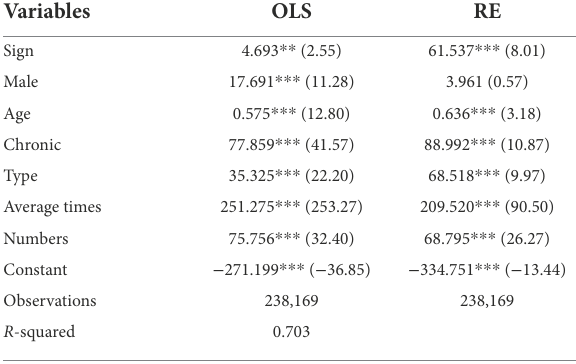
TABLE 6 Regression results of model (1) after substituting